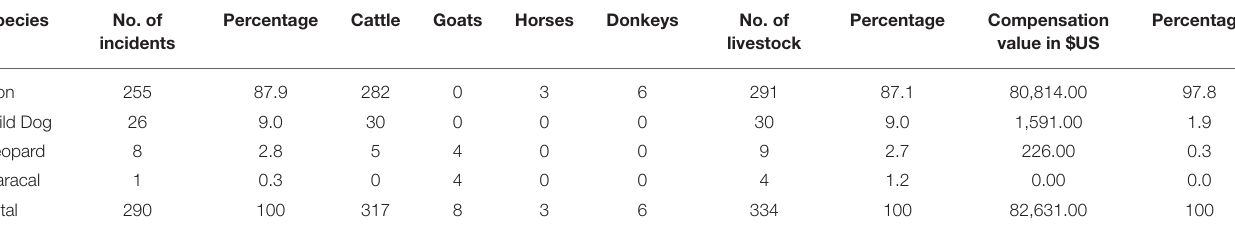
TABLE 1 | Reported livestock losses to carnivores with associated compensation value ($US), 13 May 2016–12 May 2018. Species No. of Percentage Cattle Goats Horses Donkeys No. of incidents